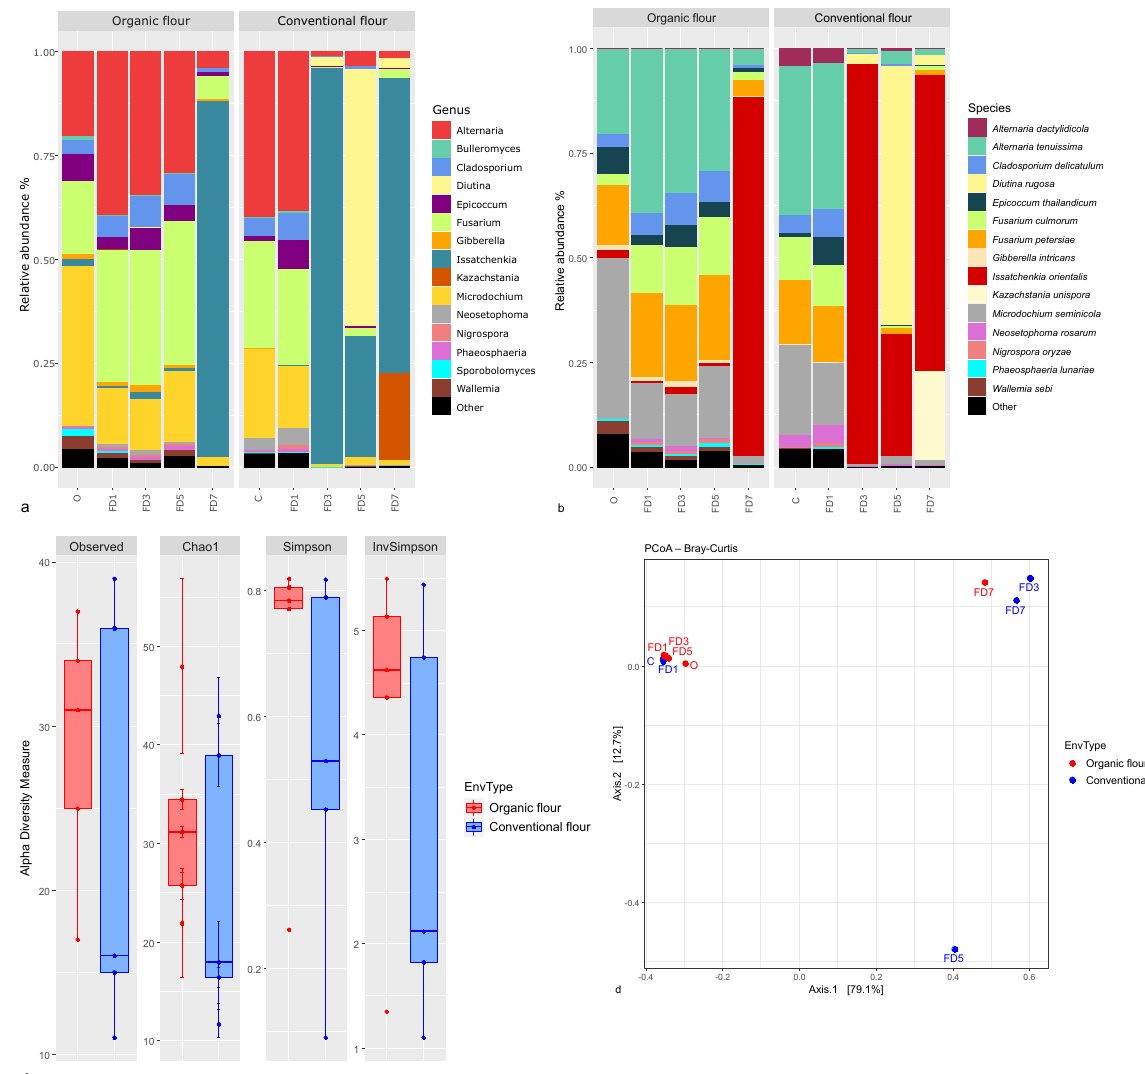
Figure 3. Fungal genus (a), species (b), alpha-diversity (c) and beta-diversity for PCoA (d) based on Bray-Curtis evaluation for organic and conventional flours and sourdough samples during leavening. O: organic whole wheat flour; C: conventional whole wheat flour; FD1 (0 h), FD3 (120 h), FD5 (168 h), and FD7 (216